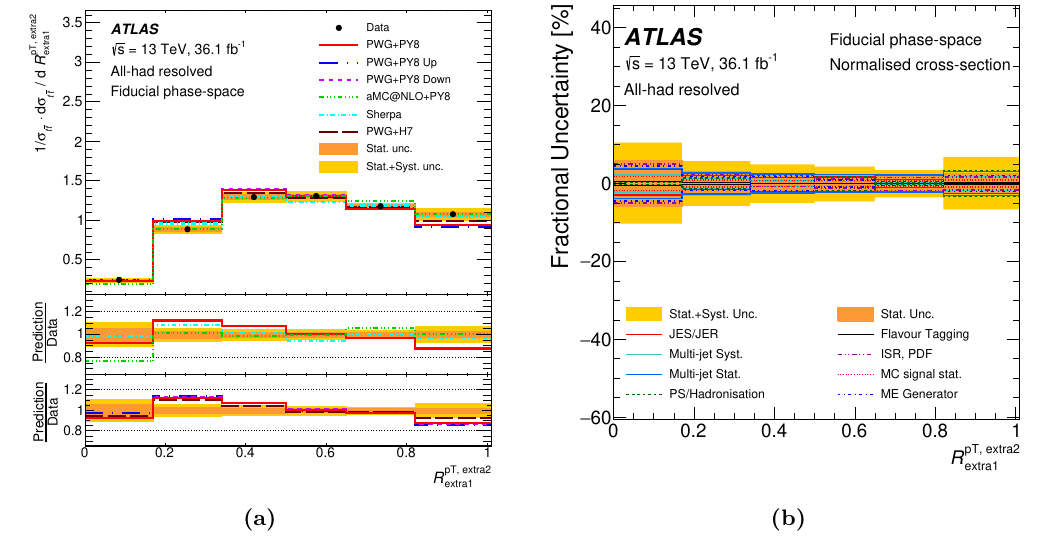
Figure 13 . Particle-level single-differential normalised cross-sections (a) as a function of the ratio of the sub-leading extra jet p to the leading extra jet p . In the top panel, the unfolded data are T T shown as black points, while lines indicate the predictions from several MC programs. Uncertainties are shown by the shaded bands. Data points are placed at the centre of each bin. The lower two panels show the ratio of the MC predictions to the unfolded data. Fractional uncertainties (b) for the normalised single-differential cross-sections as a function of the ratio of sub-leading extra jet p to the leading extra jet p . The bands represent the uncertainties in the unfolded data. Lines T T indicate the breakdown of the major components of the